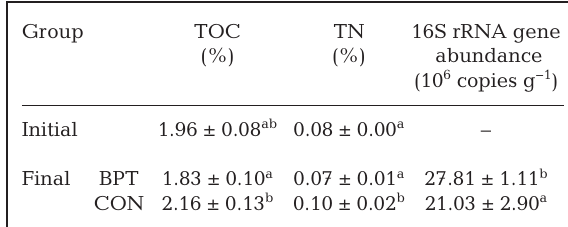
Table 4. Total organic carbon (TOC), total nitrogen (TN), and bacterial 16S rRNA gene abundance in the surface sed- iment. Data are presented as mean ± SD (n = 3). Different letters within the same column indicate significant differ- ences between the final Bellamya purificata treatment (BPT), the final control (CON), and the corresponding initial values (p <